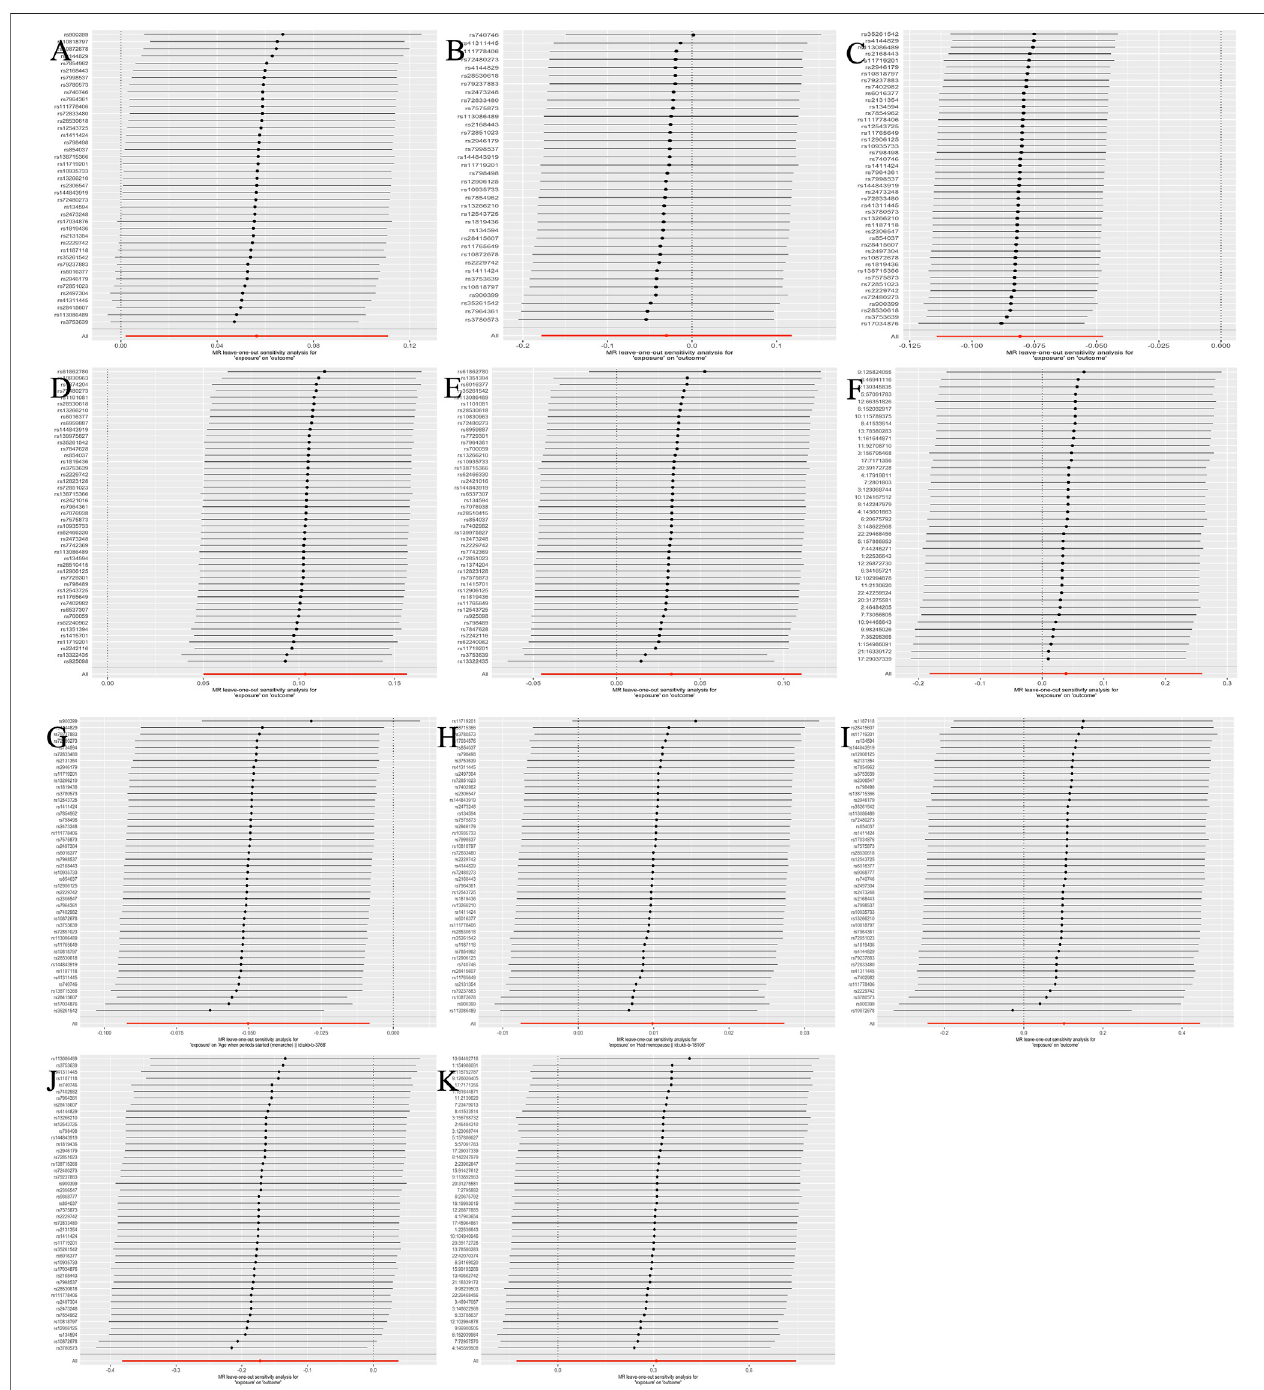
FIGURE 2 | The leave-one-out analysis plot (The estimation effects are reported per SD increase in the exposure, and error bars represent 95% con fi dence intervals).